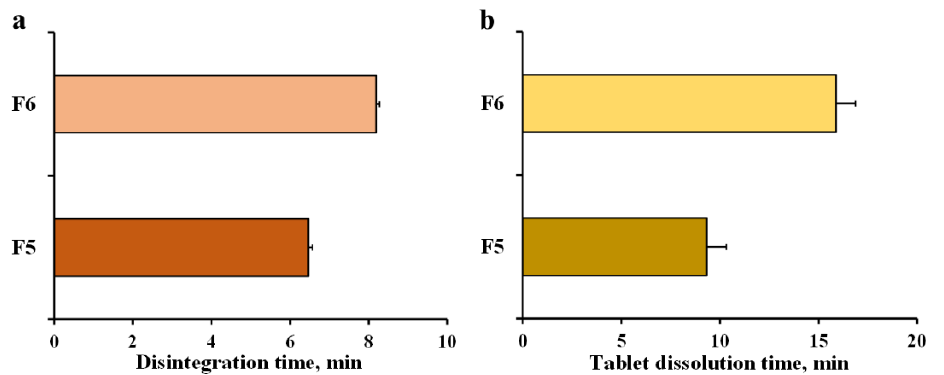
Figure 5. Disintegration time ( a ) and tablet dissolution time ( b ) of fluconazole tablets without (F5) and with (F6) sodium lauryl sulphate. Each value is the mean ± S.D., n = 3.